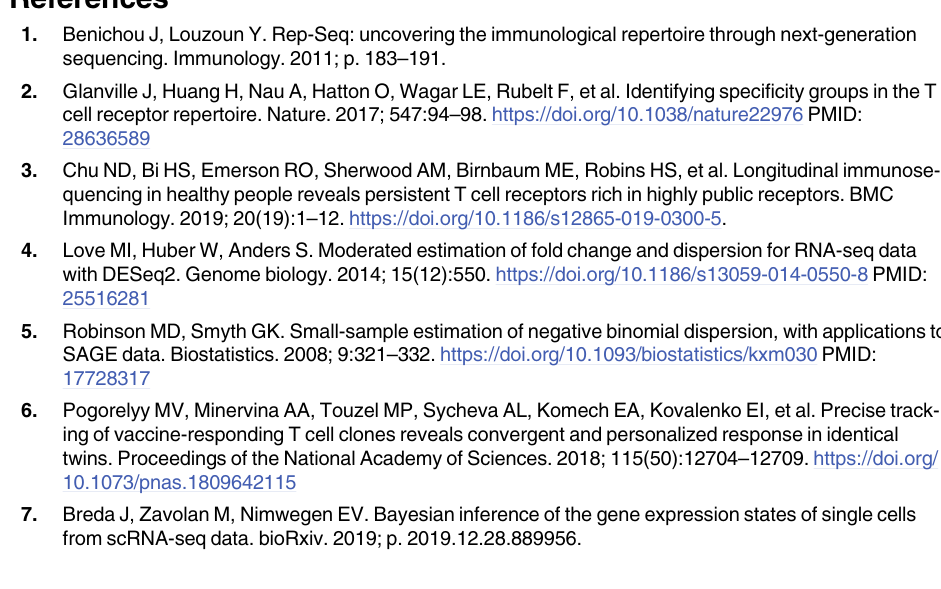
S4 Fig. Posteriors of the learned model, ρ ( s | n , n 0 ) over pairs ( n , n 0 ) for n 0 = n , with n varying over a logarithmically-spaced set of counts (left), and for n 0 given by the reverse order of this set (right). The black dot in both plots denotes the contribution of the non-responding component, / δ ( s − s ), to the posterior. (Parameters: N = 10 6 , � = 10 − 2 ). 0 (TIF) S5 Fig. Plot of confidence of expanded response versus average effect size. A significance threshold is placed according to P = 0.025, where P = P ( s � 0). null null